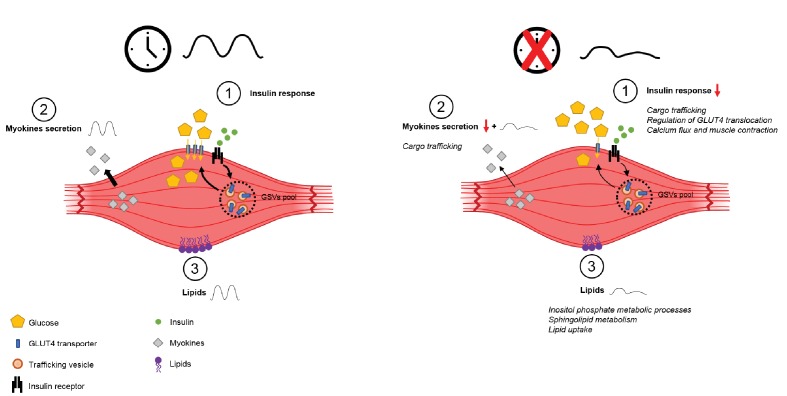
Schema summarizing impact of clock disruption on muscle metabolic function.Clock disruption leads to impaired insulin sensitivity and decrease in glucose uptake (1), causes a dysregulation of genes involved in vesicle trafficking (2) and impacts lipid metabolism and lipid metabolite oscillations (3) as reported in Loizides-Mangold et al. (2017).